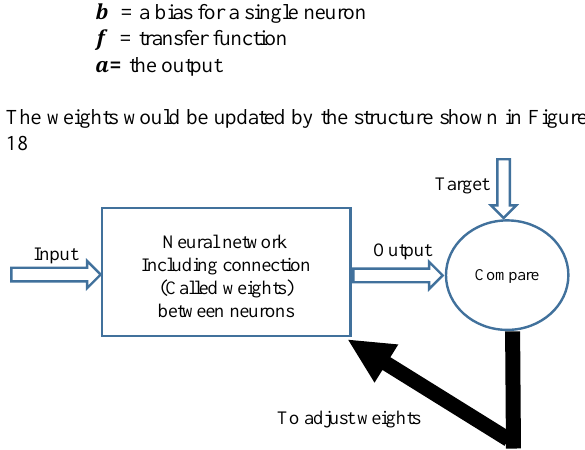
Figure 15 . PM2.5 Density for every 12 ℎ in 2012